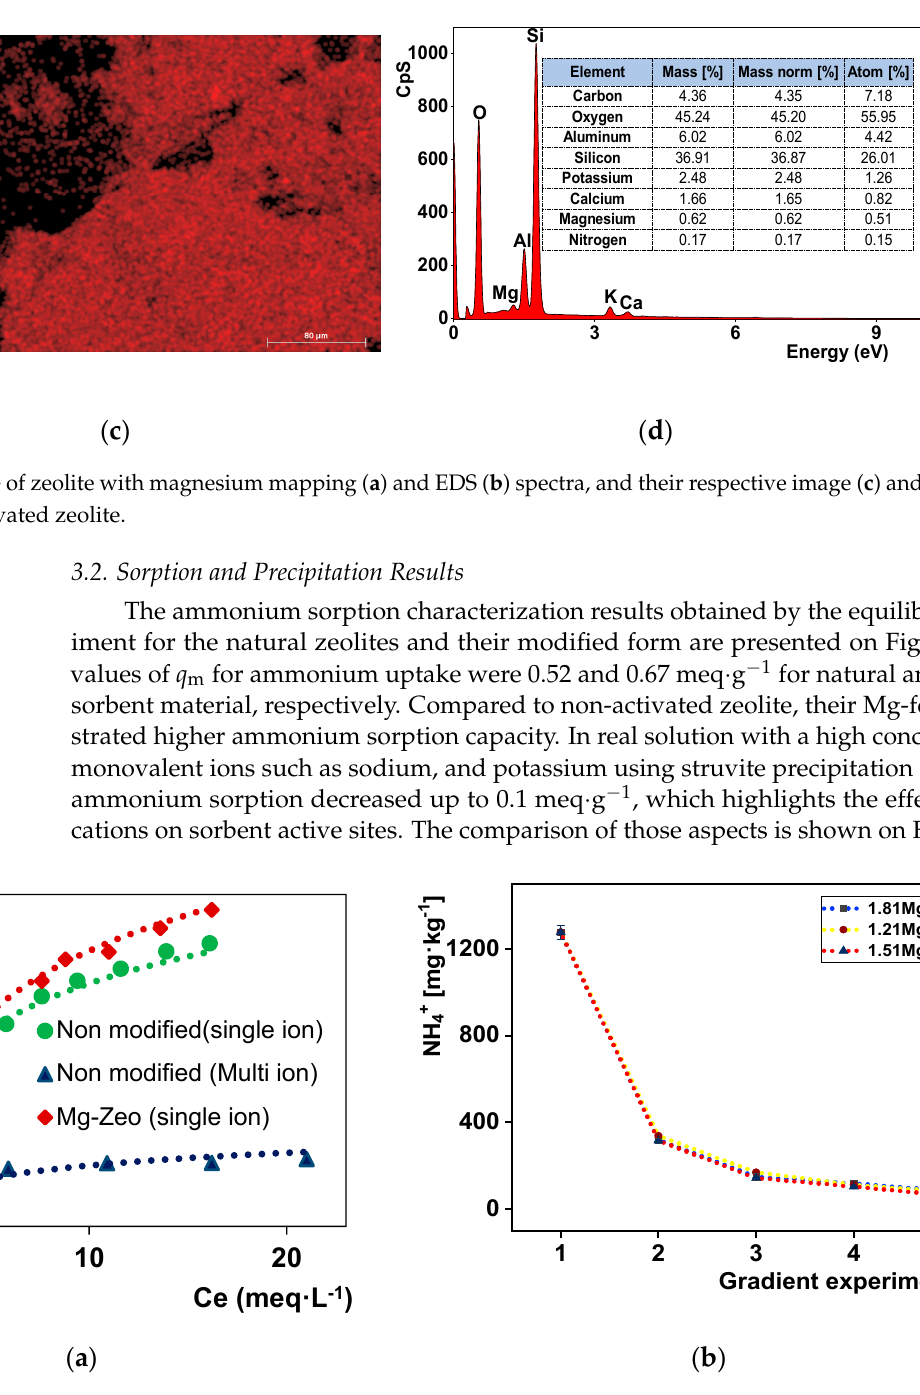
Figure 2. ( a ) Ammonium sorption equilibrium results; ( b ) gradient ammonium removal.